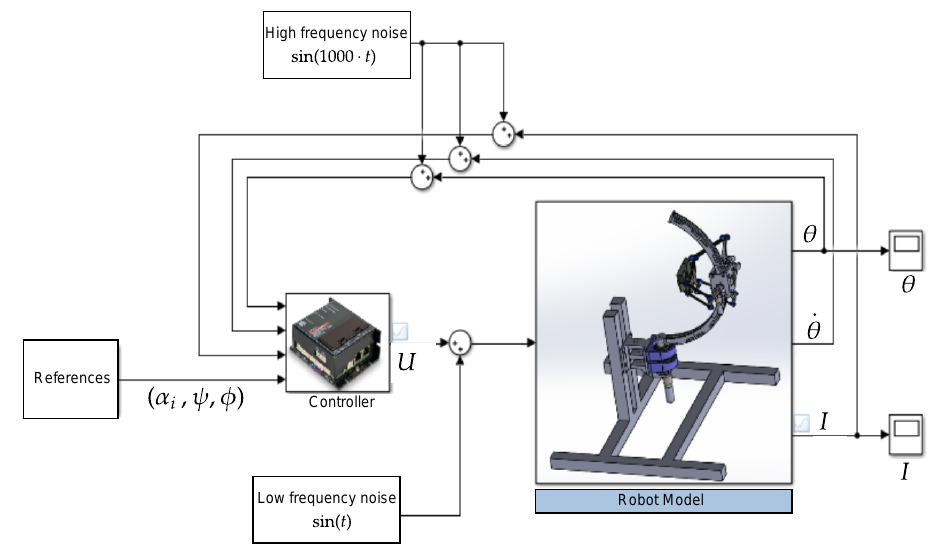
Figure 32. Simulink diagram to compare references and measurements of the angles.